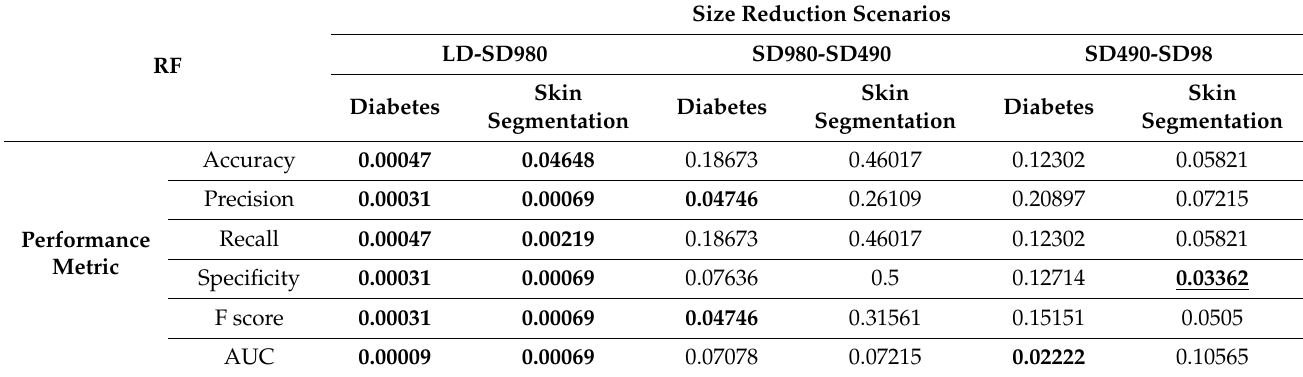
Table A9. p -values for different size reduction scenarios using the RF model; bold values are significant.